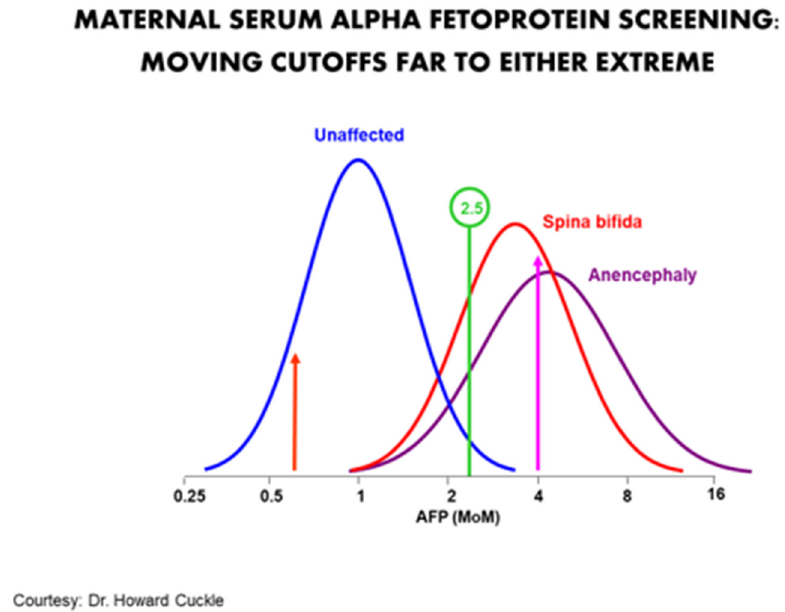
Figure 1. Typical cut-off of 2.5 MOM identifies about 90% for a 5% false positive rate. Moving the cut-off to 4 MOM would significantly increase the positive predictive value in an abnormal, but would also result in many false negatives. Moving it far to the left (about 0.6 MOM) would increase the sensitivity by almost 100% but at the price of having a screen positive rate of nearly 70%.